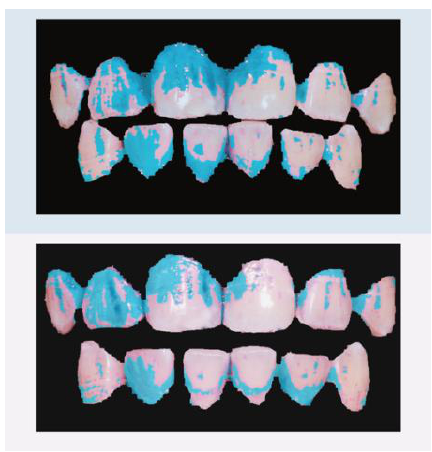
Figure 3a & 3b. Stained pixels overlaid with a transparent cyan mask to calculate percentage of plaque coverage after baseline and follow up visits respectively.